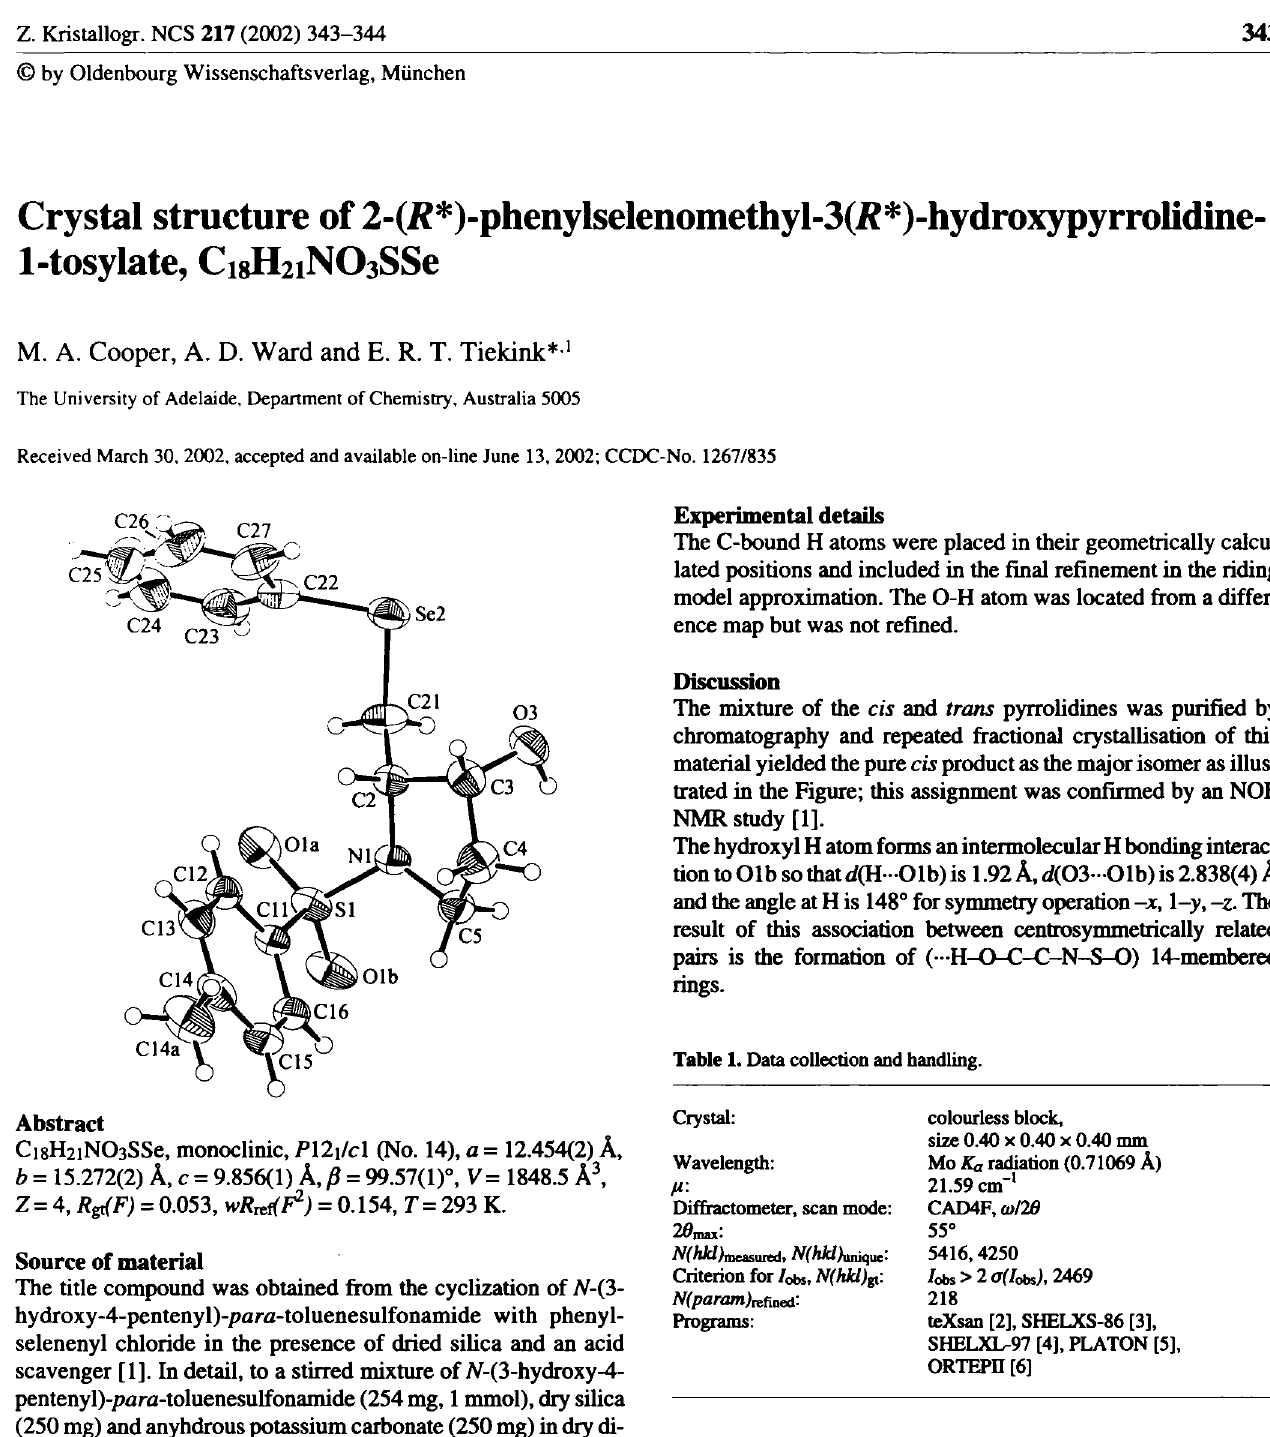
Table 2. Atomic coordinates and displacement parameters (in Â 2